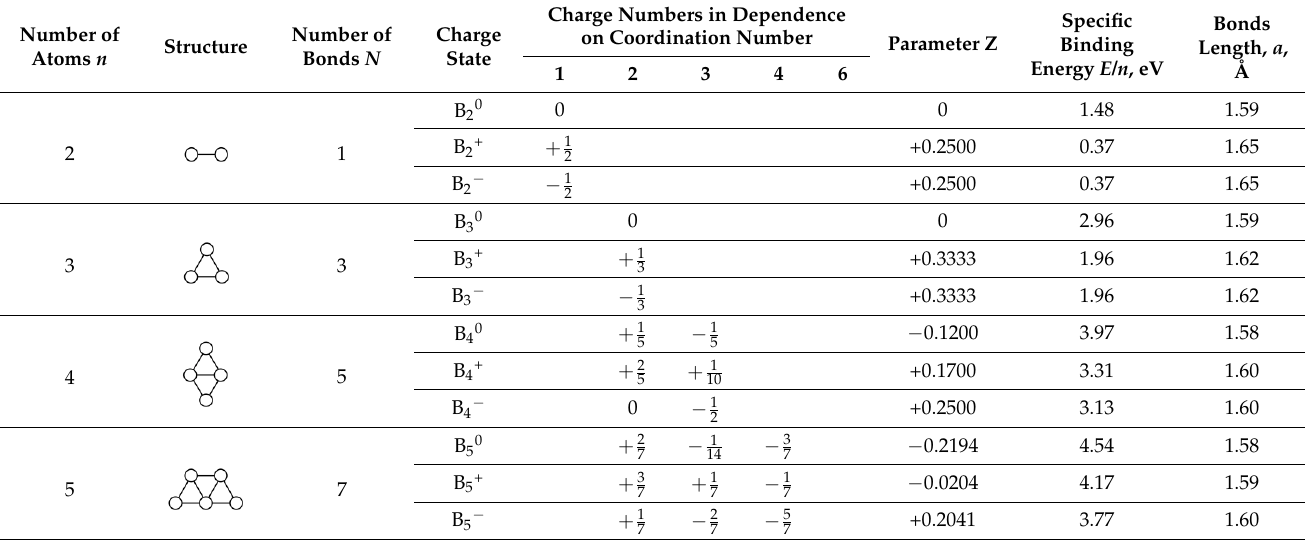
Table 1. Specific binding energy of boron small planar clusters calculated in diatomic model.